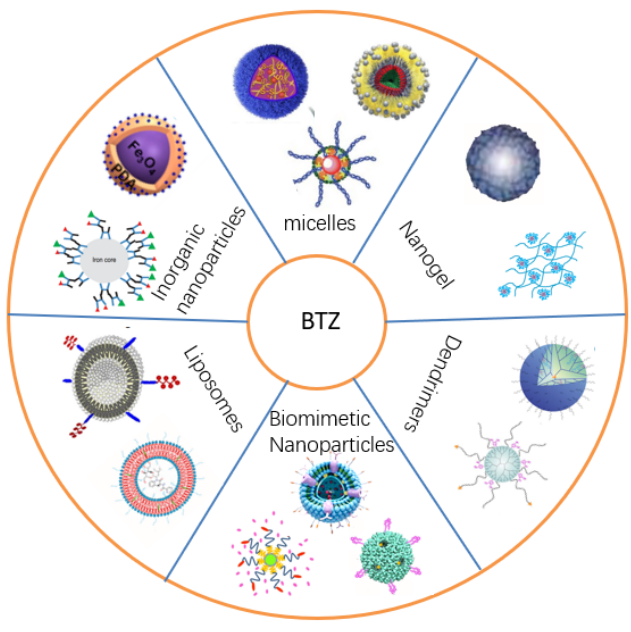
Figure 2. The nanocarriers for the delivery of BTZ.